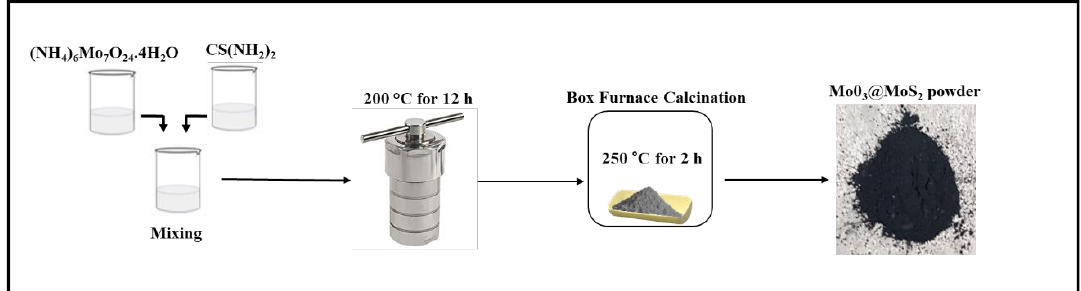
Scheme 1. Schematic of MoO 3 @MoS 2 synthesis.